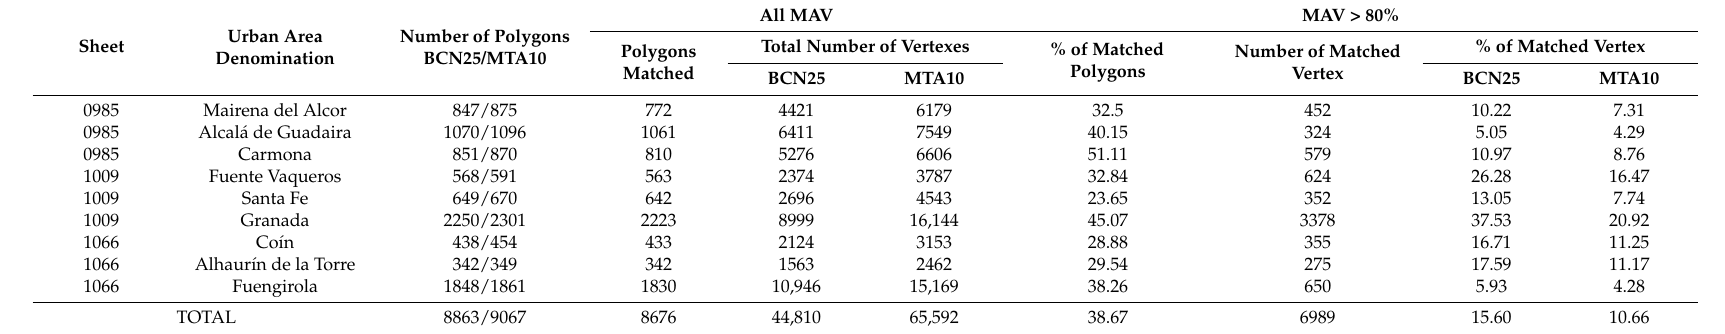
Table 5. Percentage distribution of matched points for each urban